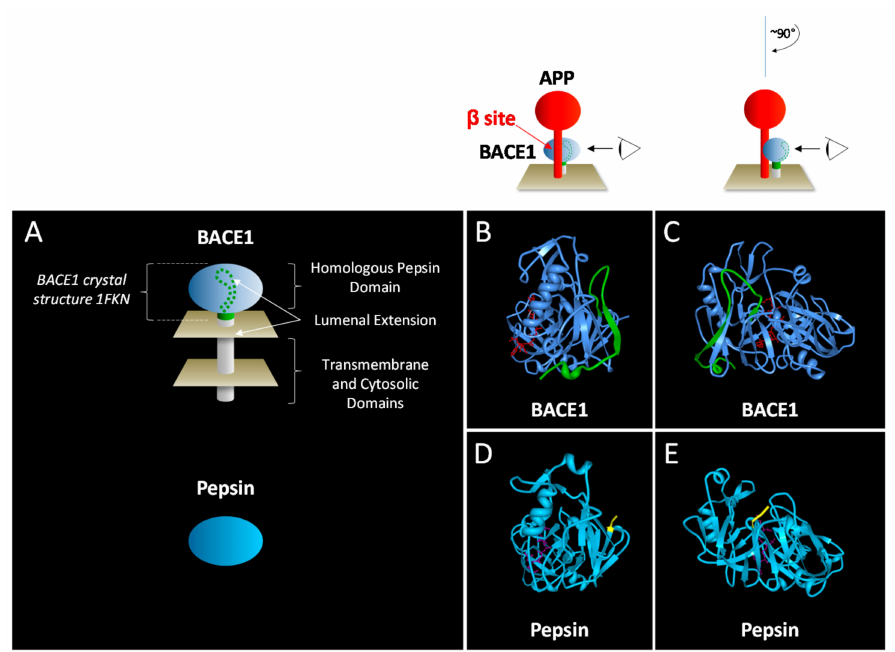
Figure 2. Lumenal extension of BACE1 interacts with the catalytic domain opposite of the active site. ( A ) Depiction scheme of BACE1 ( B , C ), Protein Data Bank code 1FKN [30]; and pepsin ( D , E ), Protein Data Bank code 1PSO [46]. The catalytic domain of BACE1 is depicted in light blue and a portion of BACE1 lumenal extension visible in the 1FKN ctrystal structure is depicted in green. ( B , D ) View of BACE1 ( B ) and pepsin ( D ) from side (BACE1 view orientation scheme above panel ( B )). Ribbon diagram of BACE1 (color scheme as in panel ( A )), with BACE1 inhibitor (atomic structure in red) marking location of the substrate APP; ( D ) Ribbon diagram of pepsin is viewed in approximately the same orientation as BACE1 in panel ( B ), with the carboxy terminal amino acids of pepsin (yellow) marking the homologous location of the C -terminal extension of BACE1. Pepsin inhibitor pepstatin A (violet atomic structure) is located in the pepsin active site. ( C , E ) View of BACE1 ( C ) and pepsin ( E ) from behind the active site (view orientation scheme above panel ( C )). Color scheme as in panels ( B , D ). Ribbon diagrams created with the RSCB PDB Protein Workshop 4.2.0 Molecular Biology Toolkit